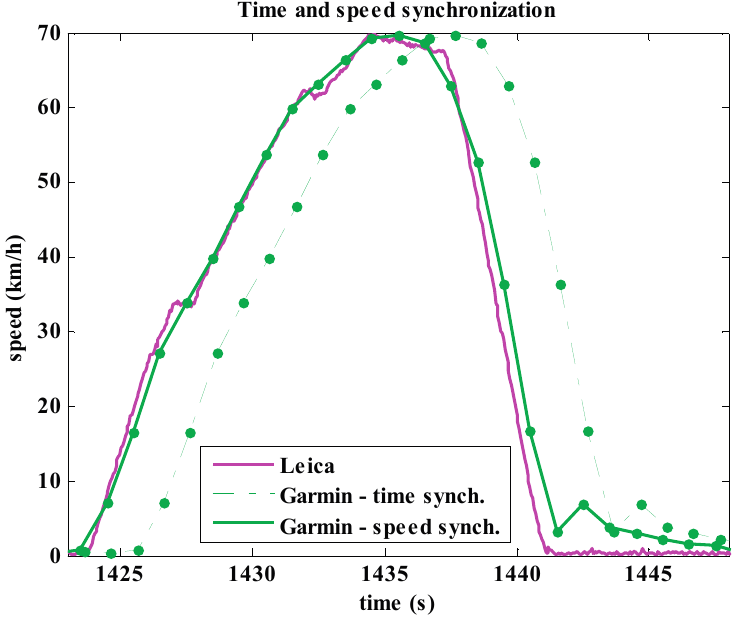
Figure 6. Garmin speed when time synchronized and speed synchronized against the reference system Leica for one selected trial. The speed latency was 2.16 s. Note: Leica had 20 Hz sampling rate (bold line) and Garmin had 1 Hz sampling rate (full circles, thin line is drawn to help the